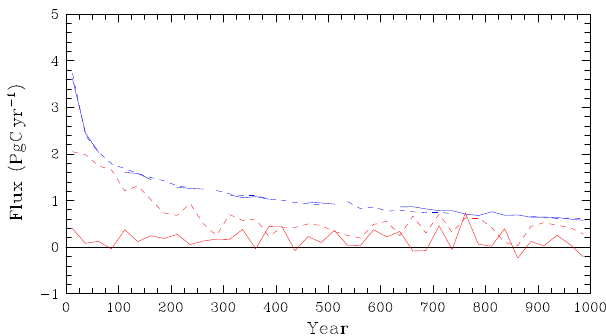
Figure 5. The 25-year mean global sea–air carbon flux (blue) and NEE (red) in PgCyr − 1 for the ProgLAI simulation (dashed) and the PresLAI simulation (solid). Ocean fluxes are missing where they are impacted by a numerical instability (see